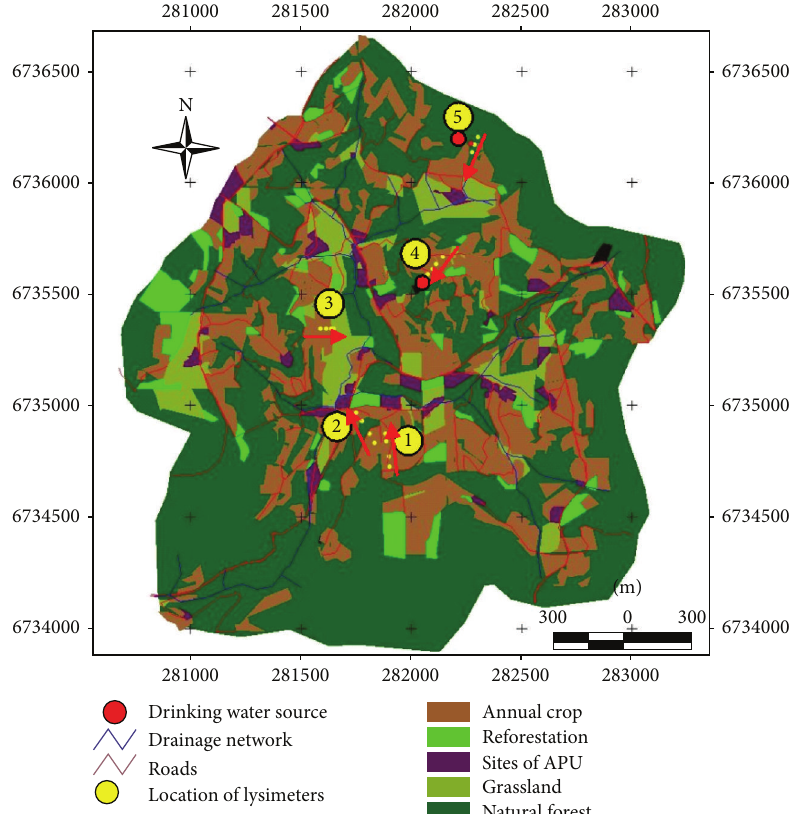
Figure 1: Collection sites on transects in the watershed. Points indicate transects in landscape and arrows indicate slope direction. APU: agricultural production